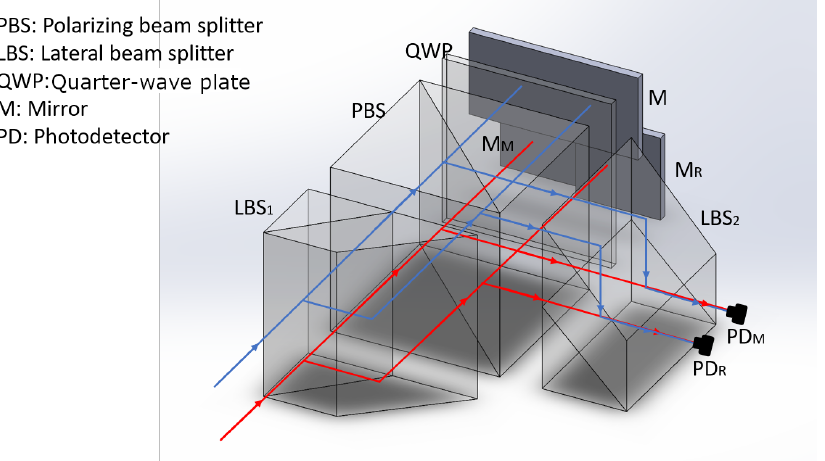
Figure 4. A diagram of the heterodyne readout used for our measurements. In this schematic, the mirrors M and M R are stationary while M M is the mirror on the test